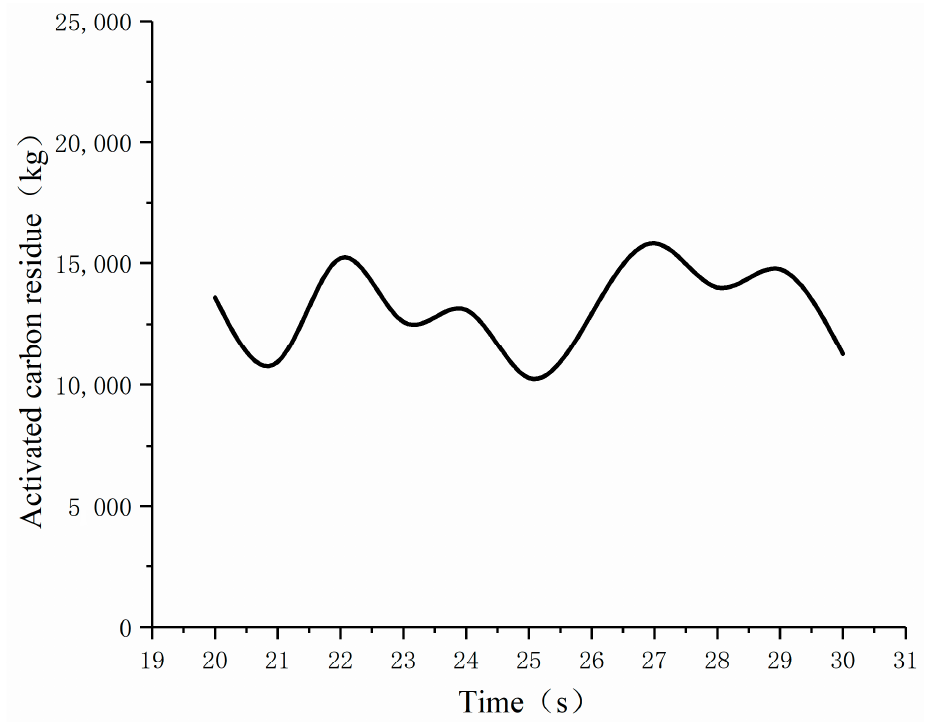
Figure 25. Dynamic change of residual char (20~30 s).